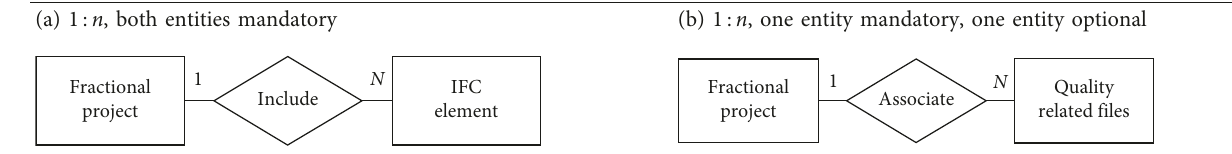
Table 14: Relationship between two